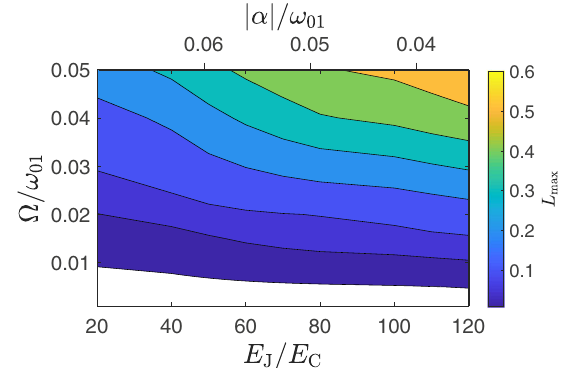
Fig. 6 Maximum state leakage for a driven transmon. Maximum state leakage for three-level transmon as a function of the relative drive coupling Ω / ω 01 and energy ratio E J / E C or ∣ α ∣ / ω 01 , correspond- ing to the N = 3 transmon in Fig. V, where α = ω 12 − ω 01 and the white region corresponds to L max < 0 : 01